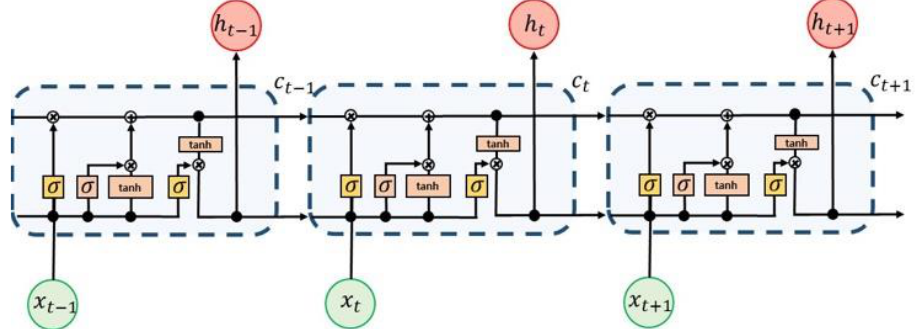
Figure 8. Block diagram of LSTM algorithm.